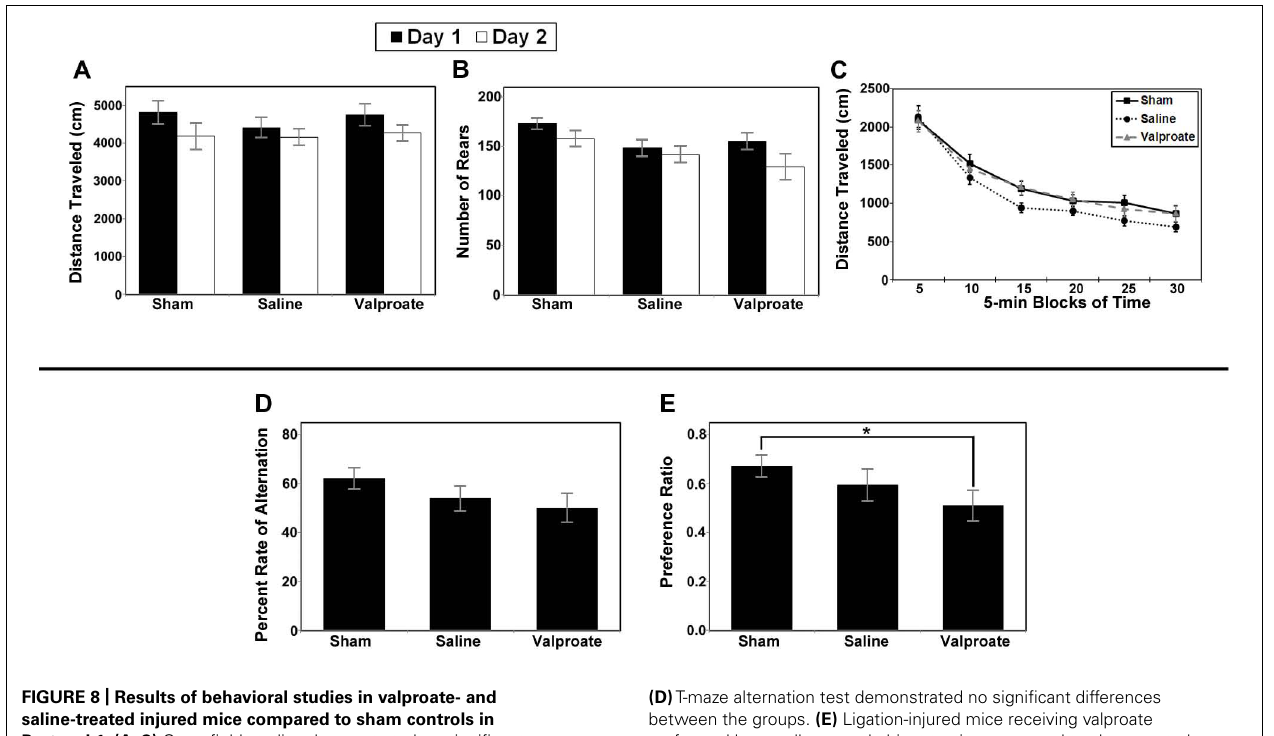
(D) T-maze alternation test demonstrated no significant differences between the groups. (E) Ligation-injured mice receiving valproate performed less well on novel object testing compared to sham controls (* p <